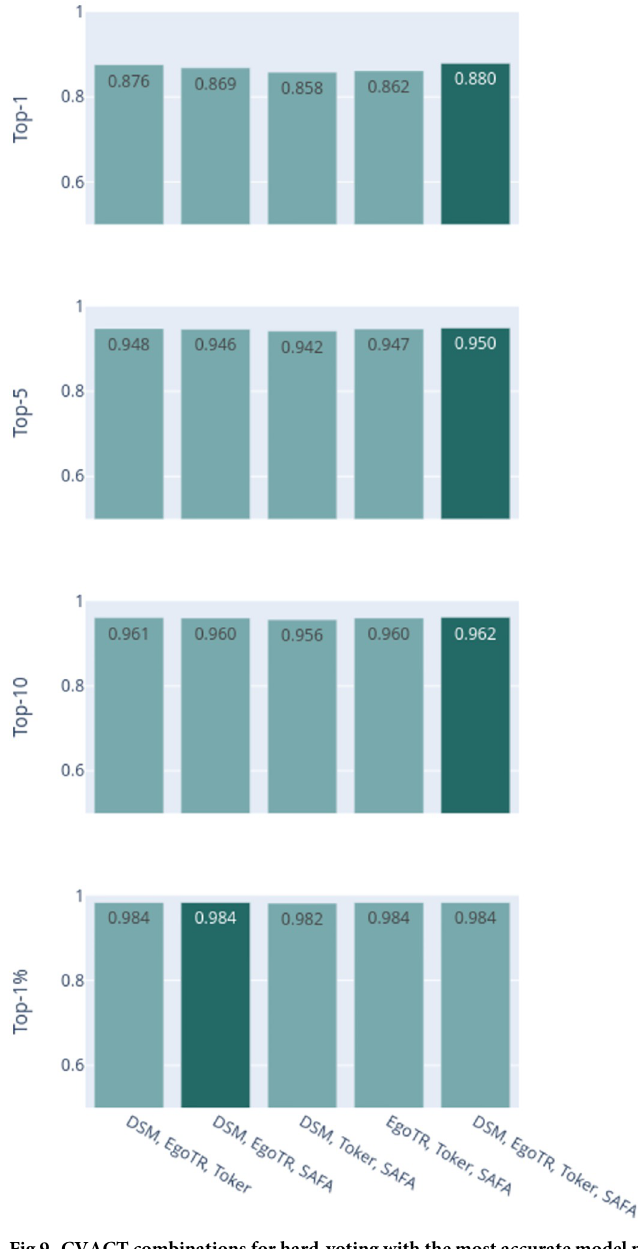
Fig 9. CVACT combinations for hard-voting with the most accurate model prediction